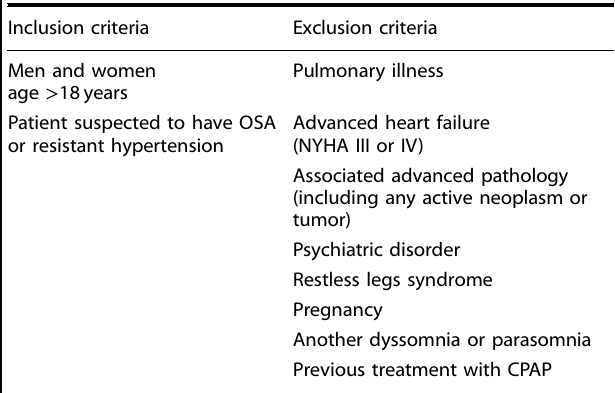
Table 1. Inclusion/exclusion criteria Inclusion